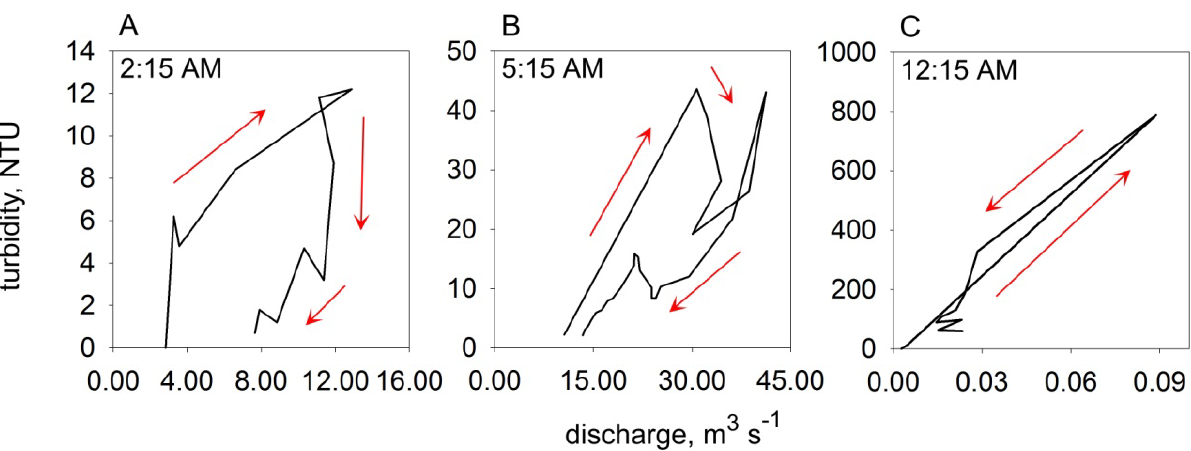
Figure 5. Hysteresis pattern progression can be seen within a multi-rise storm event sequence. ( A ) clockwise; ( B ) (less) clockwise; ( C ) linear.